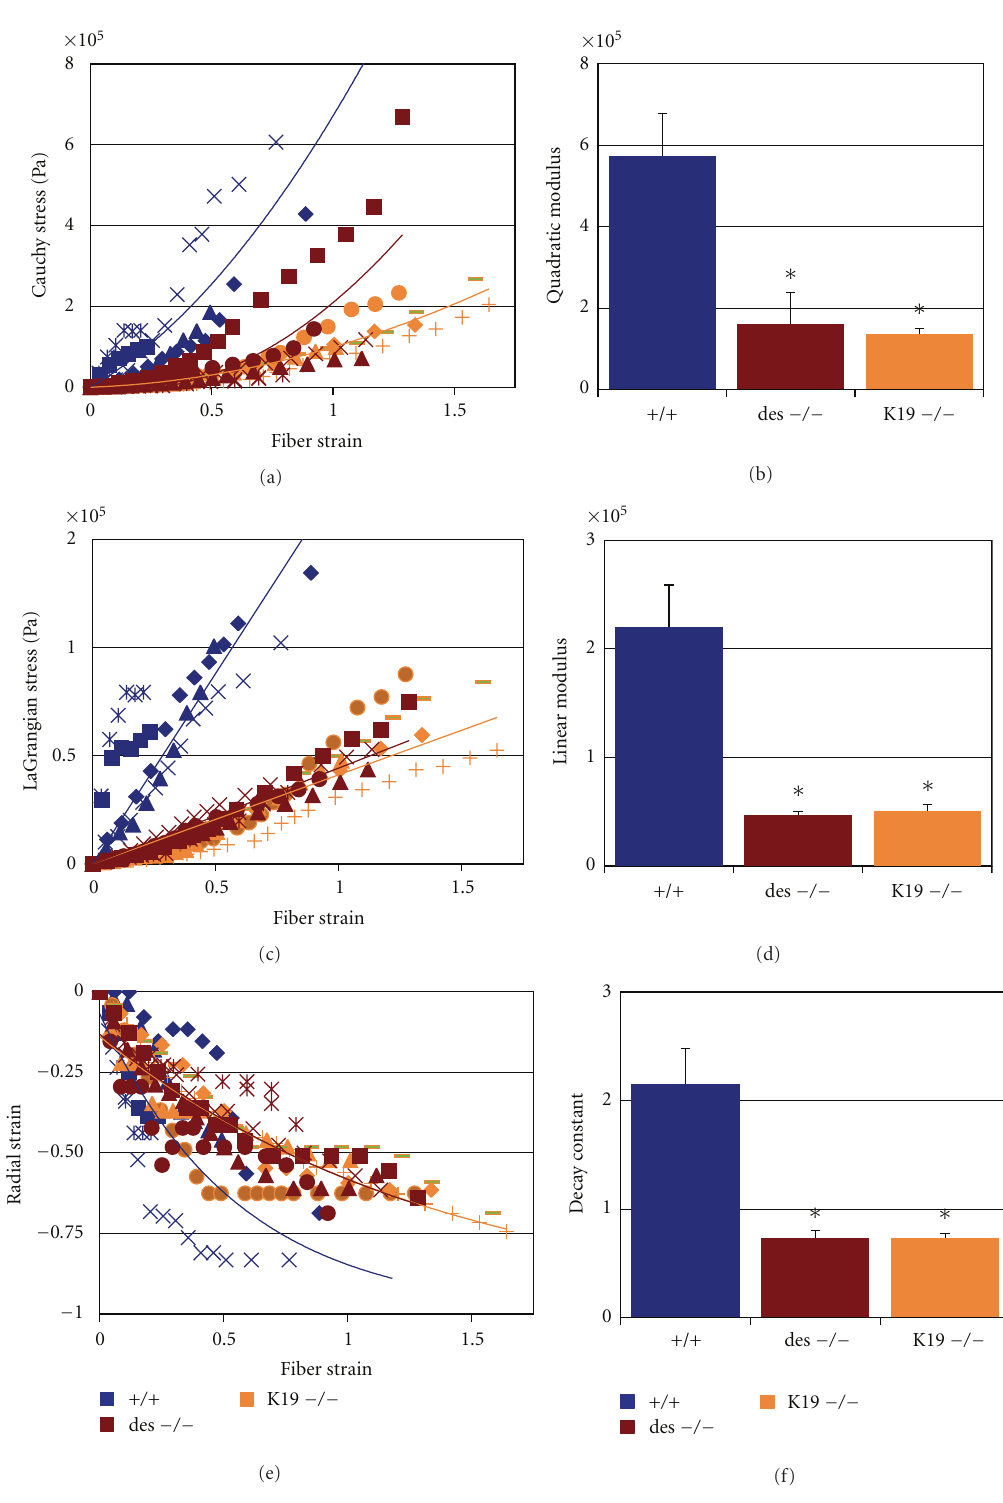
Figure 2: Mechanical response of fibers from young animals. Raw data (a, c, e) and regression coe ffi cients (b, d, f) for (a-b) Cauchy stress-fiber strain (quadratic regression); (c-d) LaGrangian stress-fiber strain (linear regression); (e-f) radial strain-fiber strain (exponential regression) for fibers from 3-month-old wild-type (blue), desmin-null (red), and K19-null (orange) animals ( n = 5 fibers/genotype). Di ff erent symbols within a color group represent data from individual experiments. Displayed regression lines in (a), (c), and (e) represent averaged coe ffi cients for individual experiments reported in (b), (d), and (f). ∗ indicates significant di ff erence from wild-type. P values are reported in the